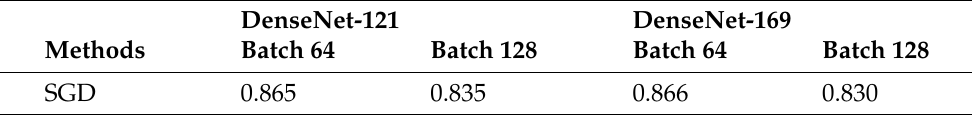
Table 8. The test accuracies of the DenseNet-121 and 169 trained by the optimization methods for the CIFAR-10 image dataset classification task. “W (Win)”, “T (Tie)”, and “L (Loss)” refer to the number of the compared methods for which HyAdamC-Basic (or HyAdamC-Scale) achieved better, equivalent, and worse test accuracies, respectively. The first and second best results are highlighted in red and orange,